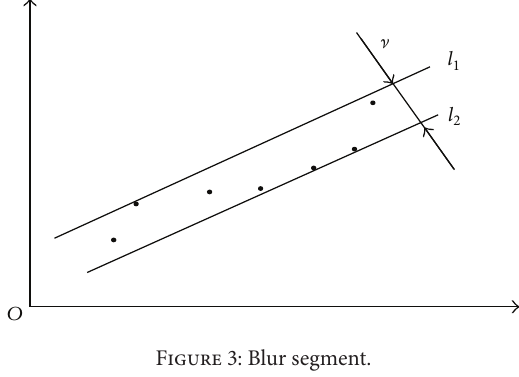
Figure 4: Segmentation by blurred segment.